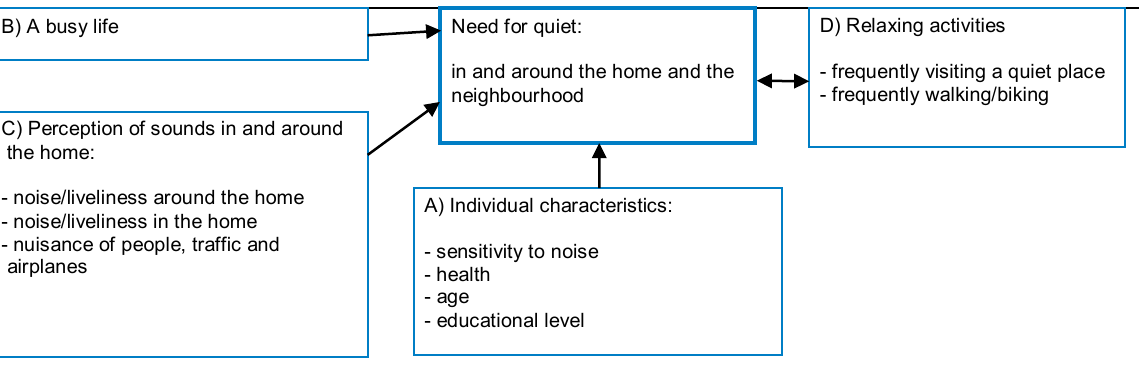
Figure 6. Models for the need for quietness.